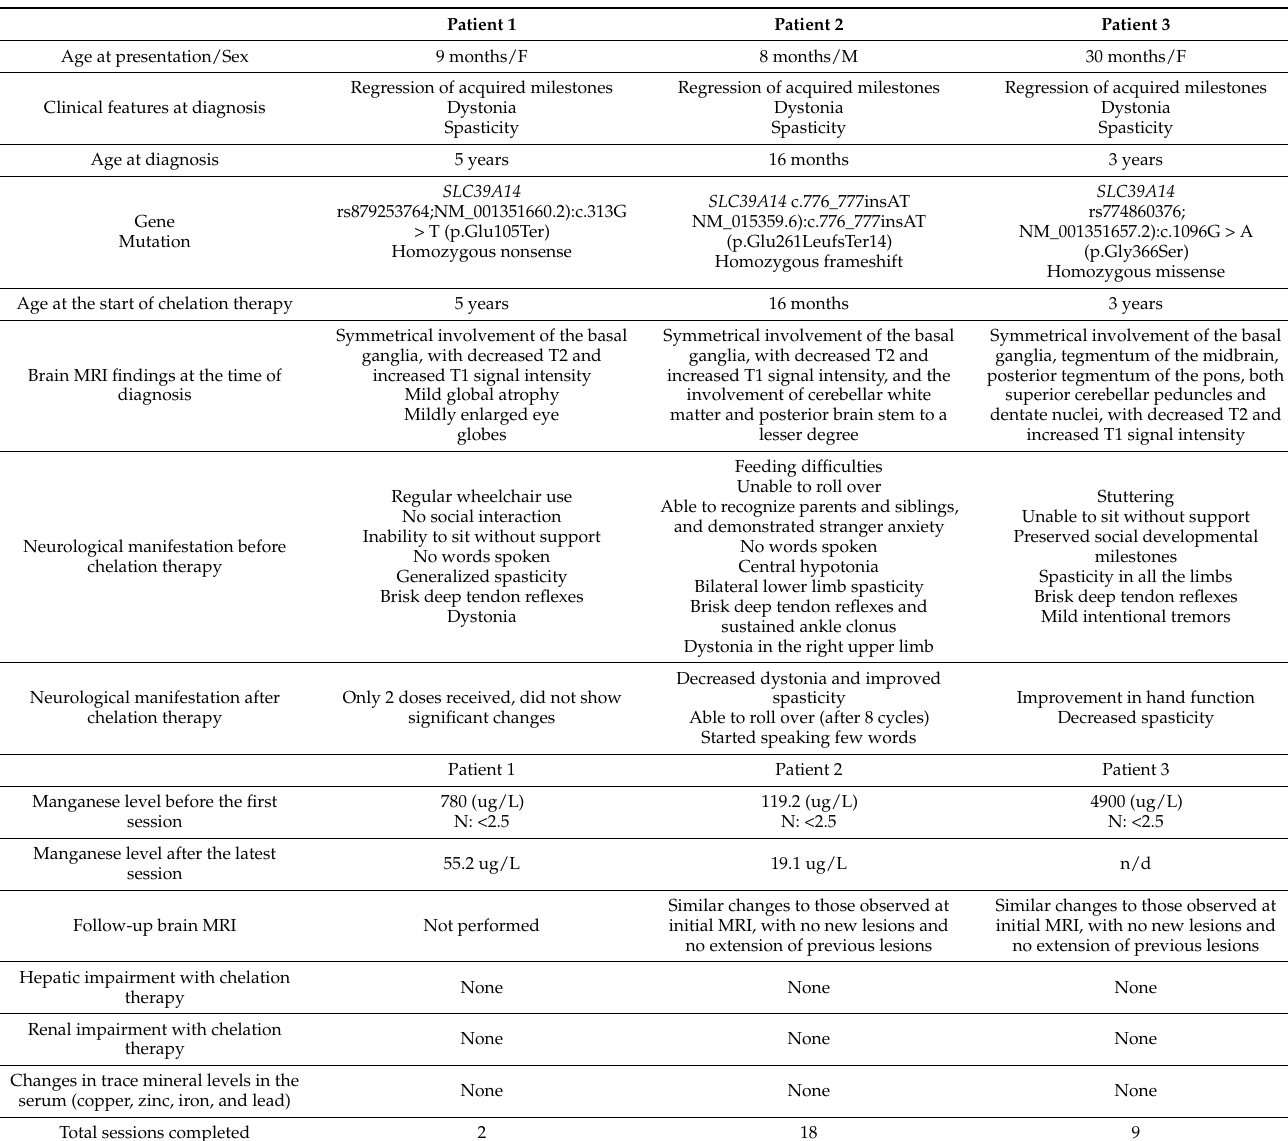
Table 1. Summary of the clinical characteristics, radiological features, and laboratory findings of the three